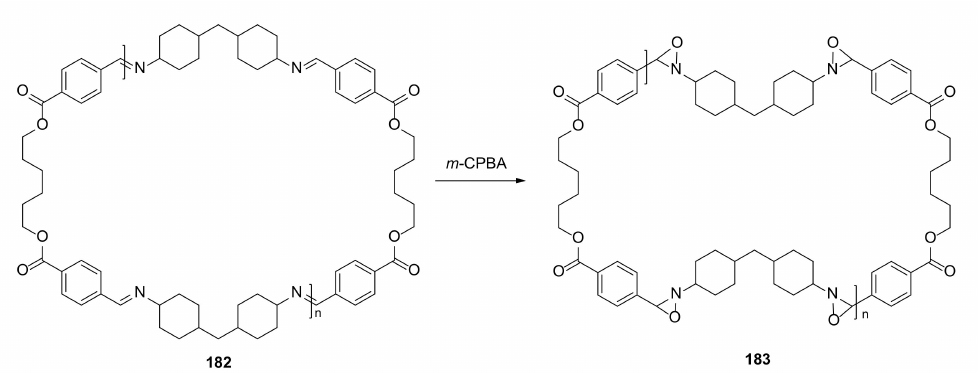
Figure 38. Oxidation of macrocyclic polymeric imine 182 ( n = 1) with m -chloroperoxybenzoic